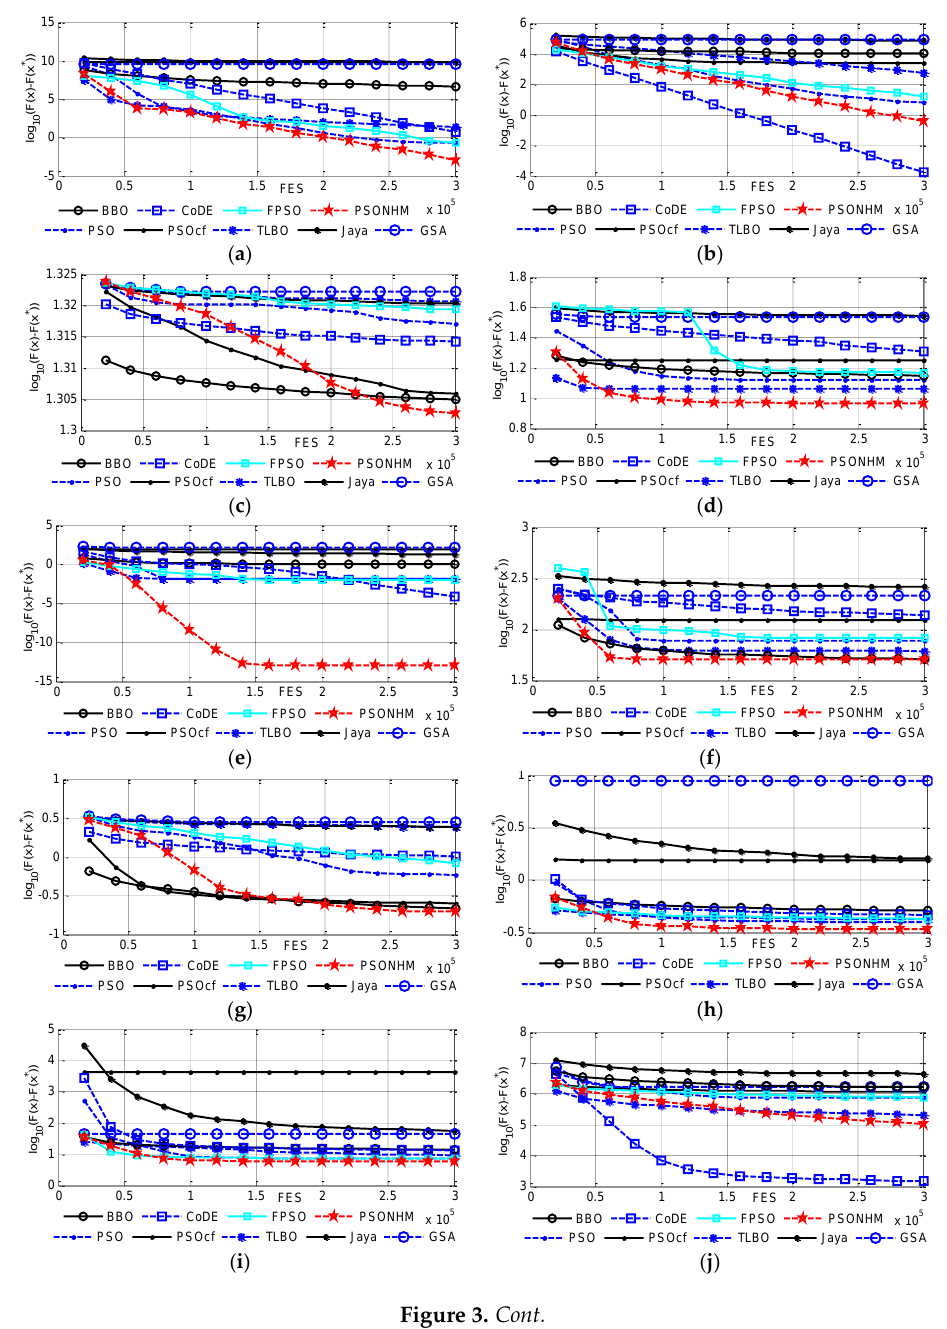
problems. The curves illustrate mean errors (in logarithmic scale) in 30 independent simulations of PSO, PSOcf, TLBO, Jaya, GSA, BBO, CoDE, FPSO and PSONHM. As mentioned above, the curves indicate that, in most problems, PSONHM either achieves a fast convergence or behaves similarly to it.